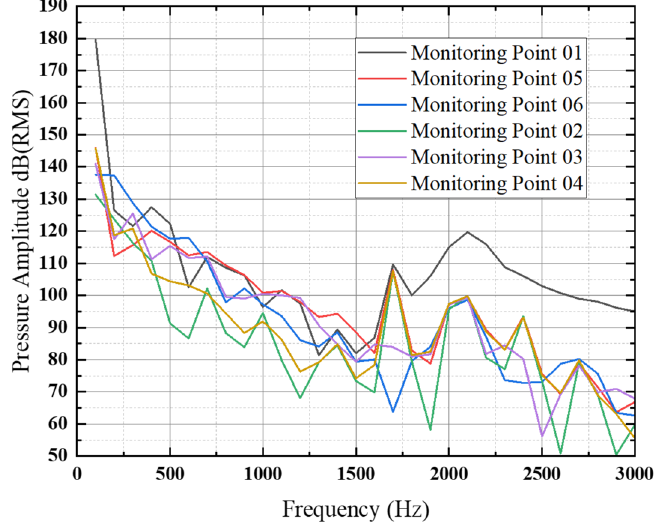
Figure 24. Line graph of the frequency response curve of the 3000 Hz near-field sound pressure level of the standard nozzle.